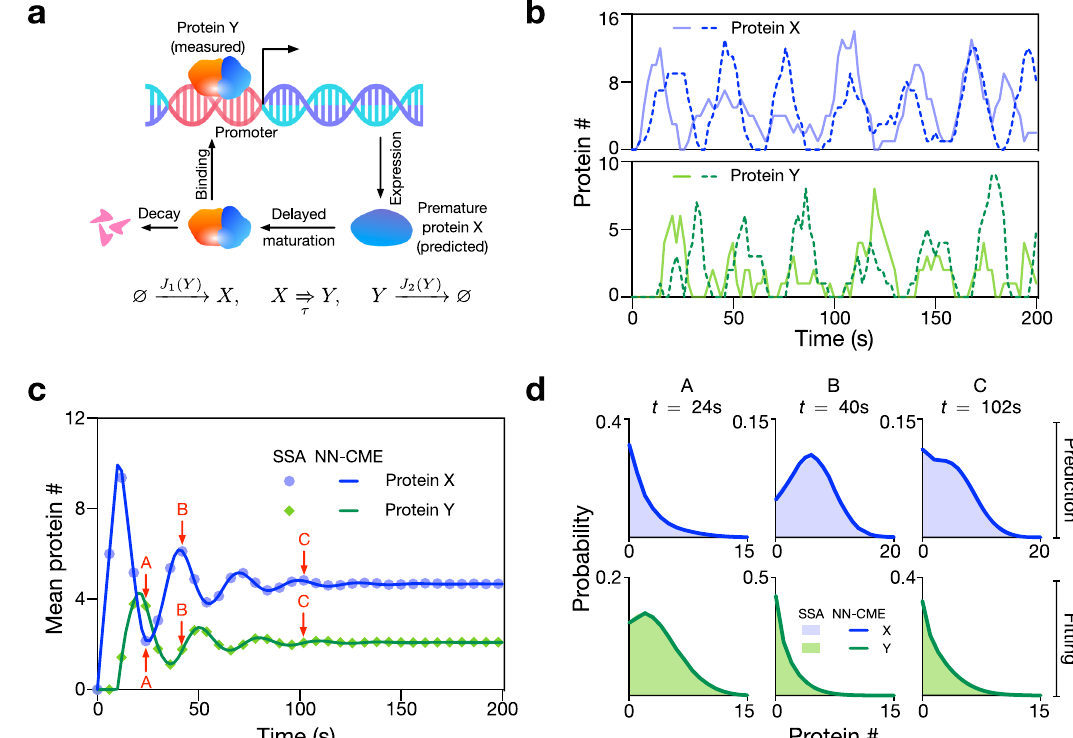
Fig. 6 NN-CME accurately predicts the properties of a stochastic auto-regulatory model of oscillatory gene expression when only partial data are used for ANN training. a Illustration of a model of auto-regulation whereby a protein X is transcribed by a gene, then it is transformed after a delay time τ into a mature protein Y , which binds the promoter and represses transcription of X . The functions J 1 ( Y ) and J 2 ( Y ) can be found in SI Note 7. b Two typical SSA simulations of proteins X and Y , clearly showing that single-cell oscillations while noisy, they are sustained. c , d The NN-CME is obtained from training the ANN using only protein Y data from SSA simulations of the delay model of the auto-regulatory model. Surprisingly, the NN-CME ’ s solution for the temporal variation of the mean number of both proteins X and Y , and for their distributions is in excellent agreement with that of the SSA. Note the distributions in ( d ) are for the three time points labelled A, B and C in ( c ). The rate constants and other parameters related to the ANN ’ s training are speci fi ed in SI Table